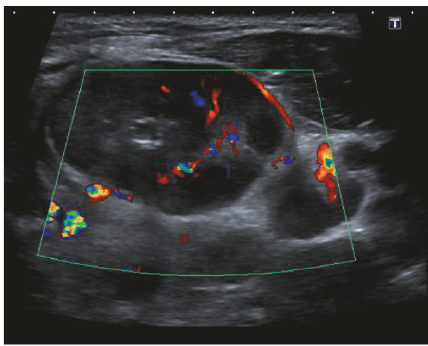
Figure 5: Ultrasound scan of the lesion in question showing colour Doppler flow in the posterior aspect of the lesion only.